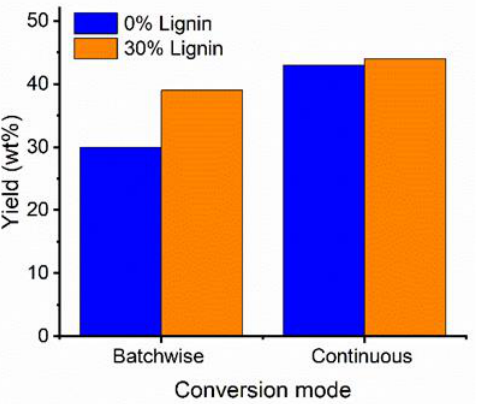
Figure 10. Gravimetric CF yield of System P precursors containing 0 or 30 wt% lignin using batchwise and continuous conversion.